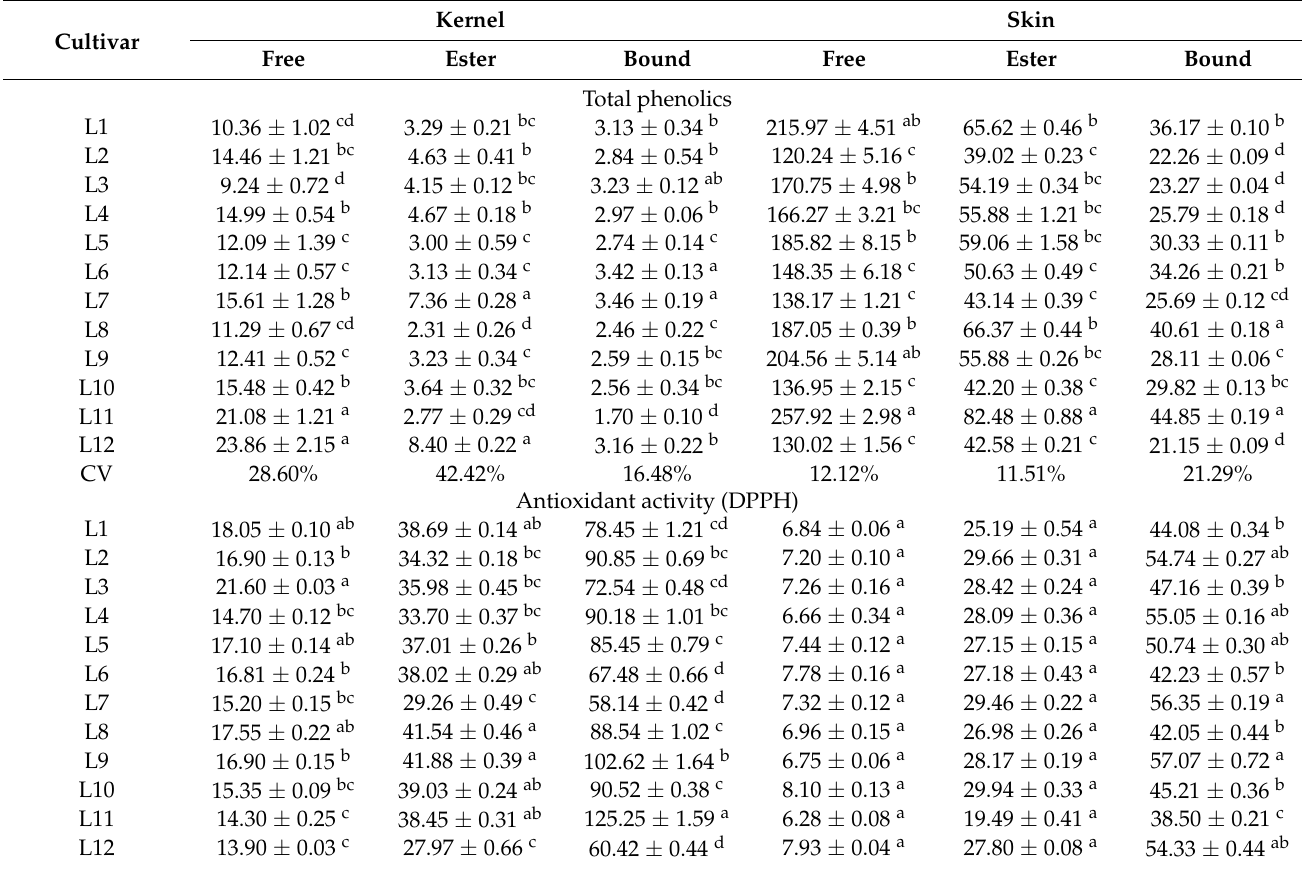
Table 1. The contents (mg/g dry weight) and DPPH scavenging capacity ( µ g/mL) of total phenolics in kernels and skins of 12 walnut